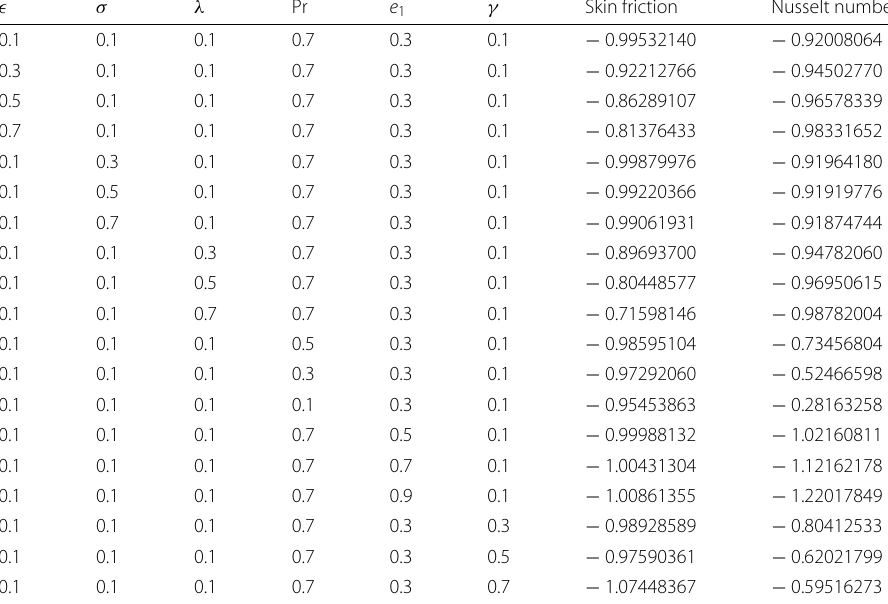
Table 1 Impact of different parameters on Skin friction coefficient and Nusselt